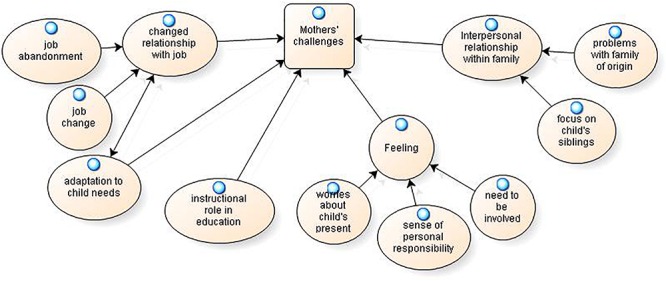
Mothers’ challenges.